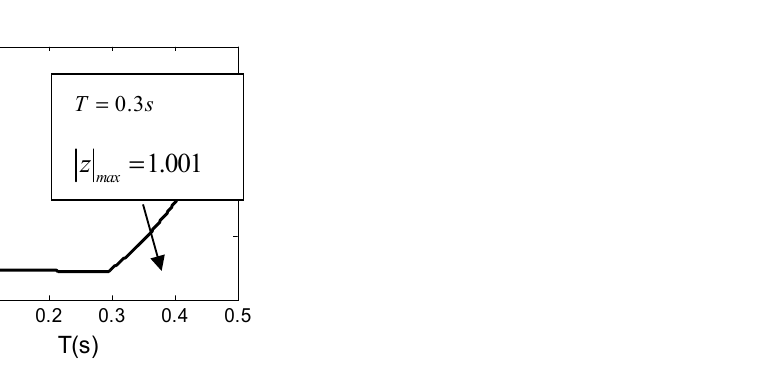
Figure 4. Maximum module | z |